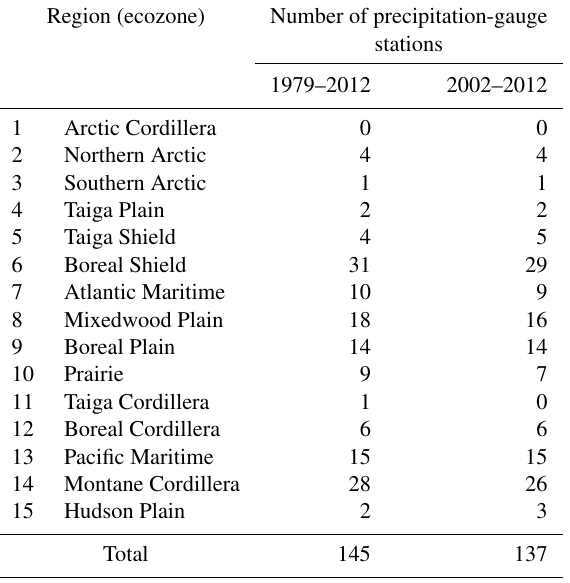
Table 4. Number of precipitation-gauge stations within each eco-